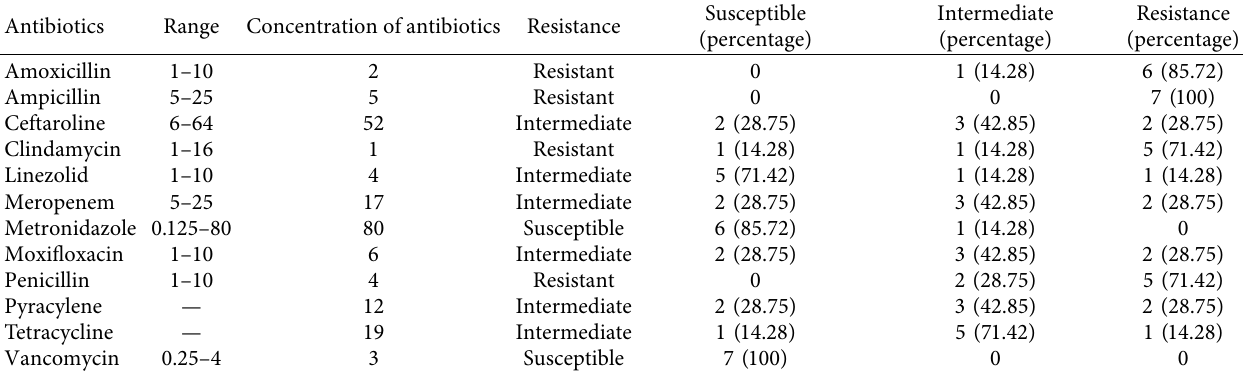
Table 2: Examining resistance and susceptibility of C . difcile strains in chicken, duck, partridge, and quail